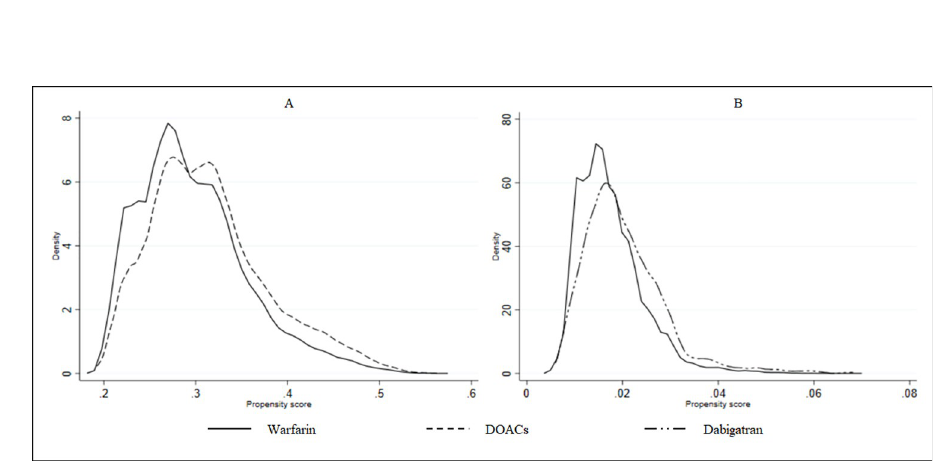
Fig 1. Propensity score distribution for warfarin, combined-DOACs, and dabigatran. Note: DOACs = Direct Oral Anticoagulants.